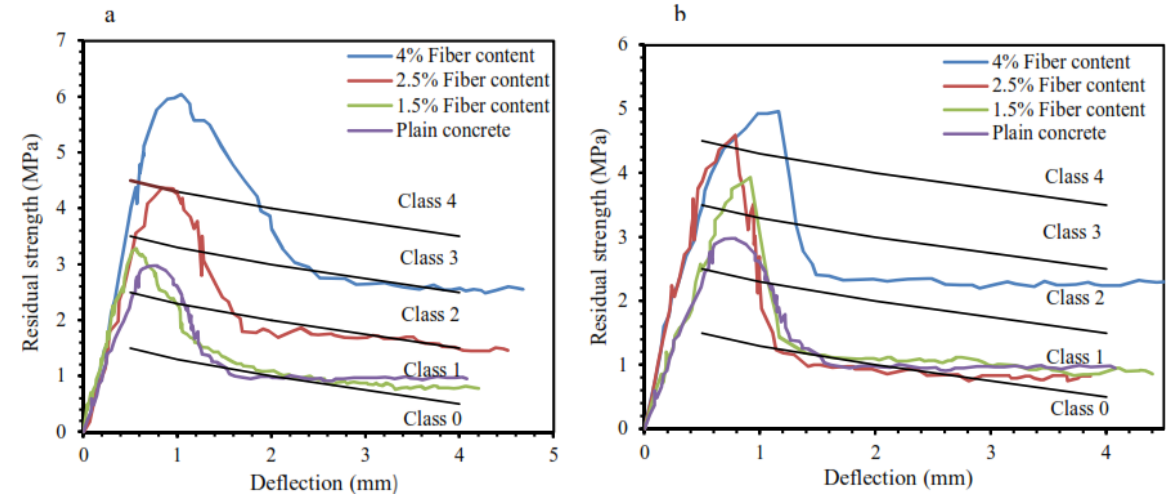
Figure 14: Residual classification of flexural strength in accordance with EFNARC